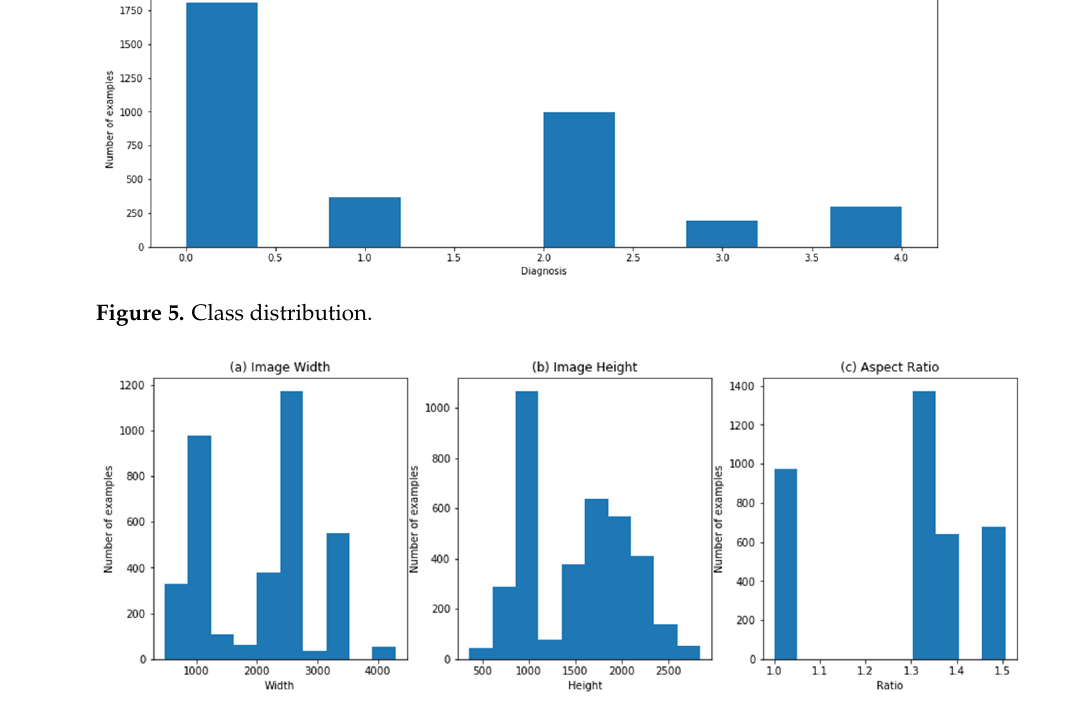
Figure 6. ( a ) Image width; ( b ) image height; ( c ) image aspect ratio.